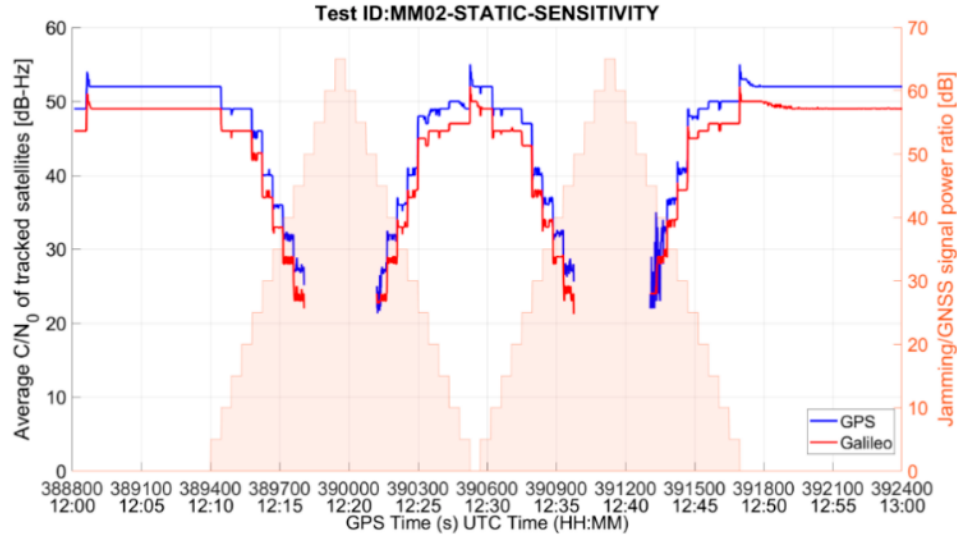
Figure 4. Average C/N 0 of tracked satellites for MM RUT in the presence of threat signature 02.